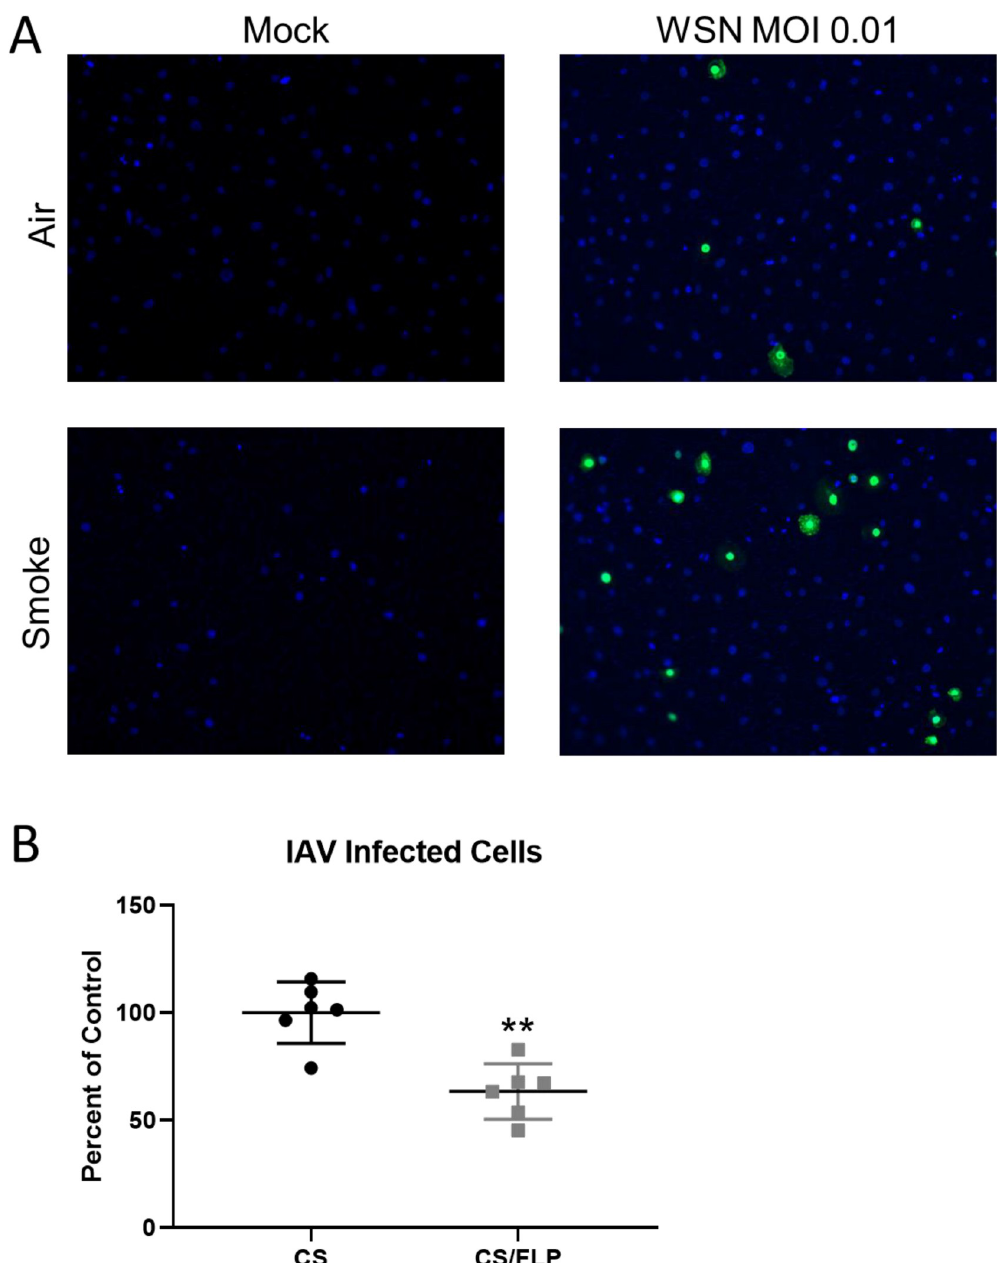
Fig 7. Smoke increases infectivity of SAEC with IAV. Primary human SAEC were exposed to either air or cigarette smoke for 60 minutes at the air-liquid interface. (A) Cells were then infected with WSN IAV at an MOI of 0.01 and fixed 24 hours post-infection and stained for IAV NP. (B) Smoke-exposed SAEC were treated with filipinIII or vehicle prior to infection with MOI 0.1 of IAV. 24 hours after infection, cells were fixed, stained, and imaged for IAV NP and the percent of NP positive cells was